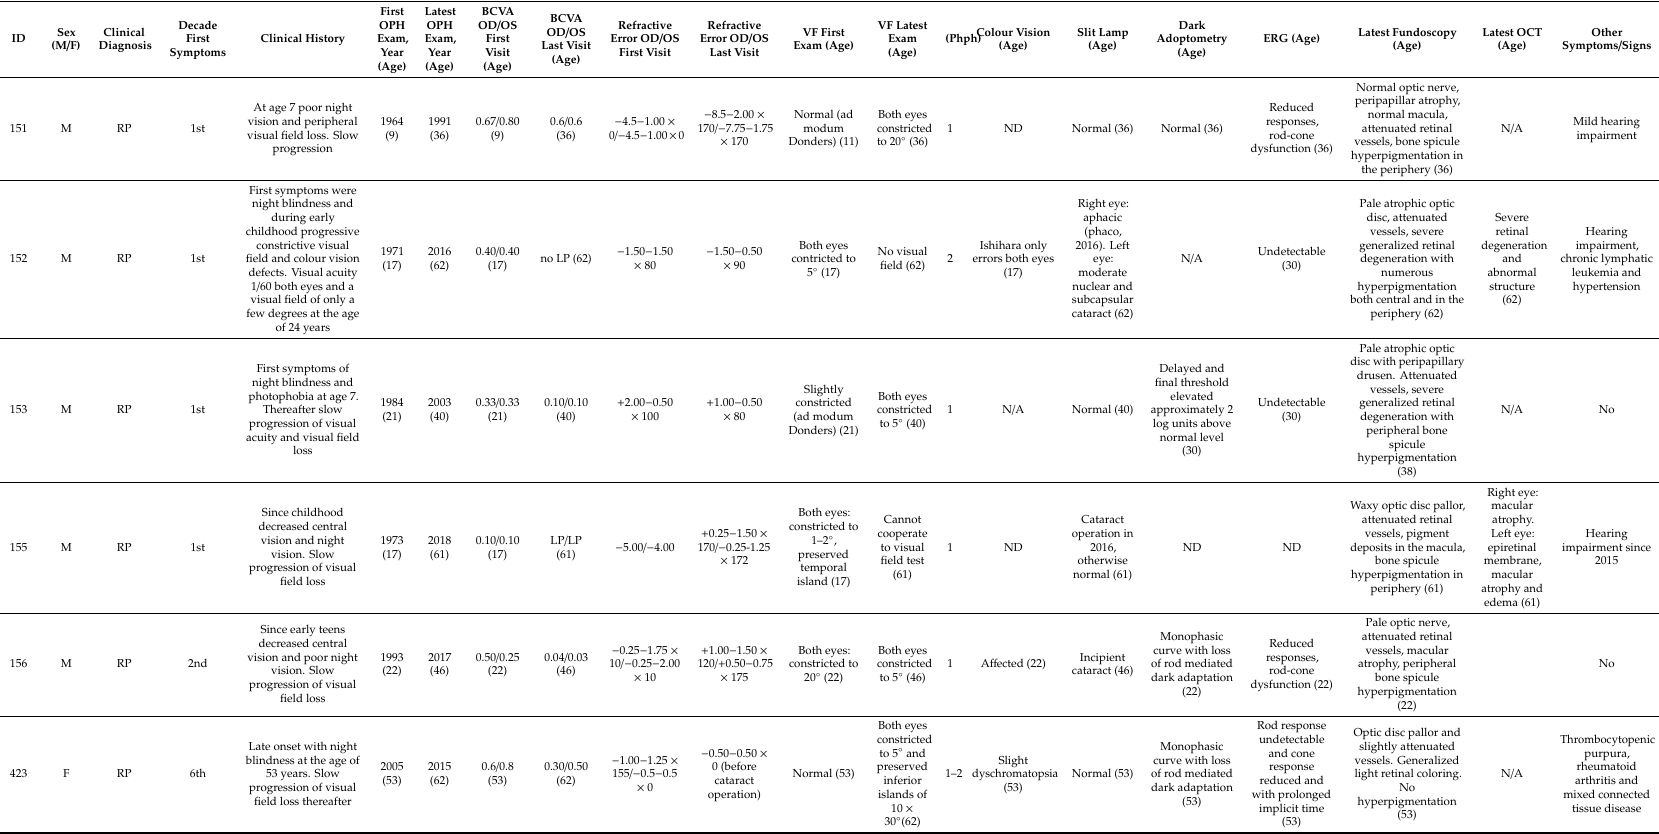
Table 1. Clinical